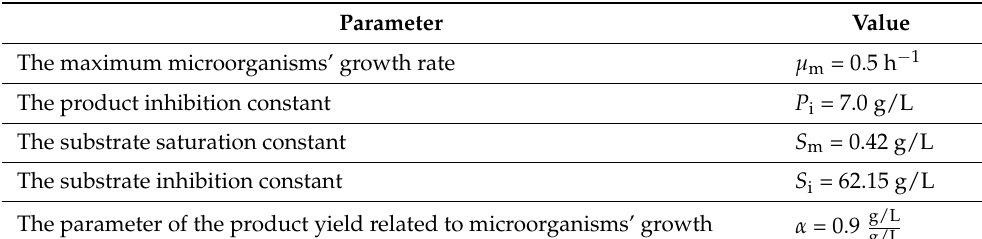
Table 2. Parameters of the Mathematical Model for the Original Fermentation Process in the Studied Laboratory Batch Bioreactor where fully activated kefir grains were